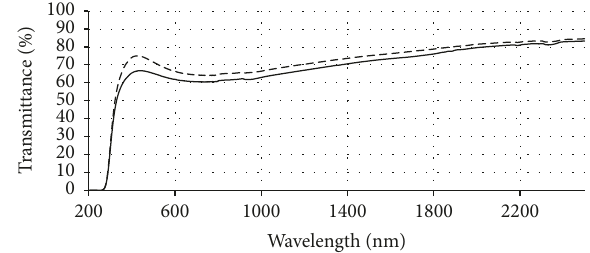
Figure 2: Effect of heating the sample for one hour at 100 ∘ C.